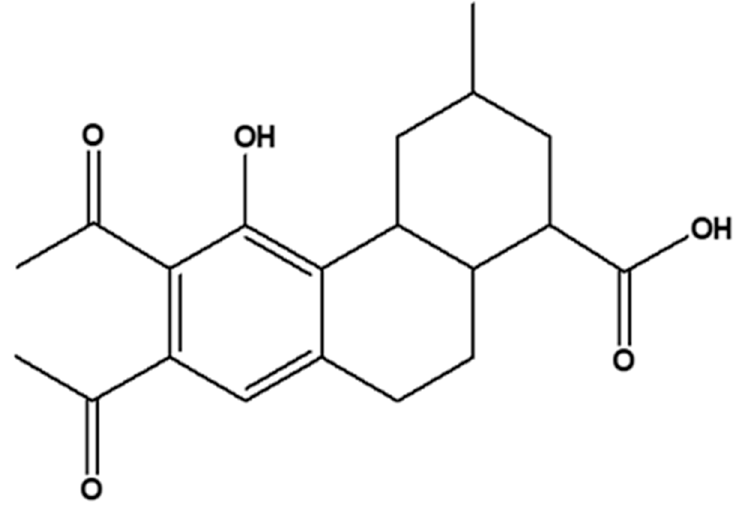
Figure 4. Structure of compound E3 (6,7-dipropanone-5-hydroxyphenyl-3-methylphenanthrene-1- carboxylic acid).